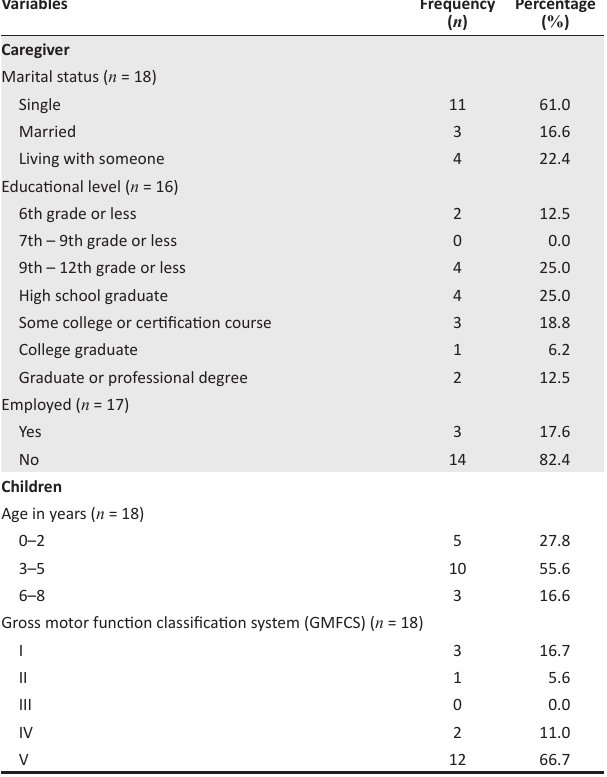
TABLE 2: Demographic information of the caregivers and their children ( n = 18). Variables